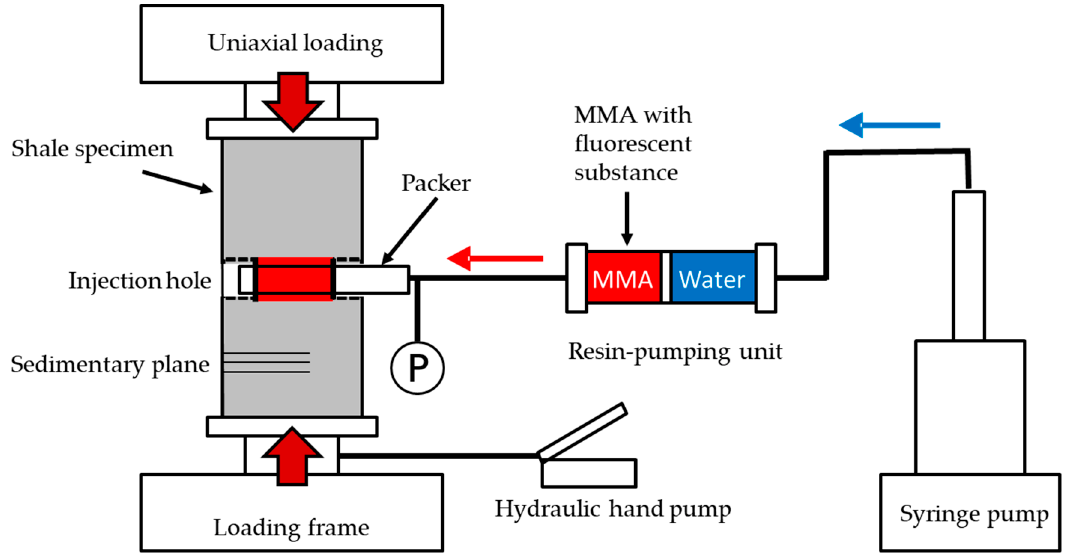
Figure 1. Schematic of the experimental system for visualizing hydraulically induced fractures.